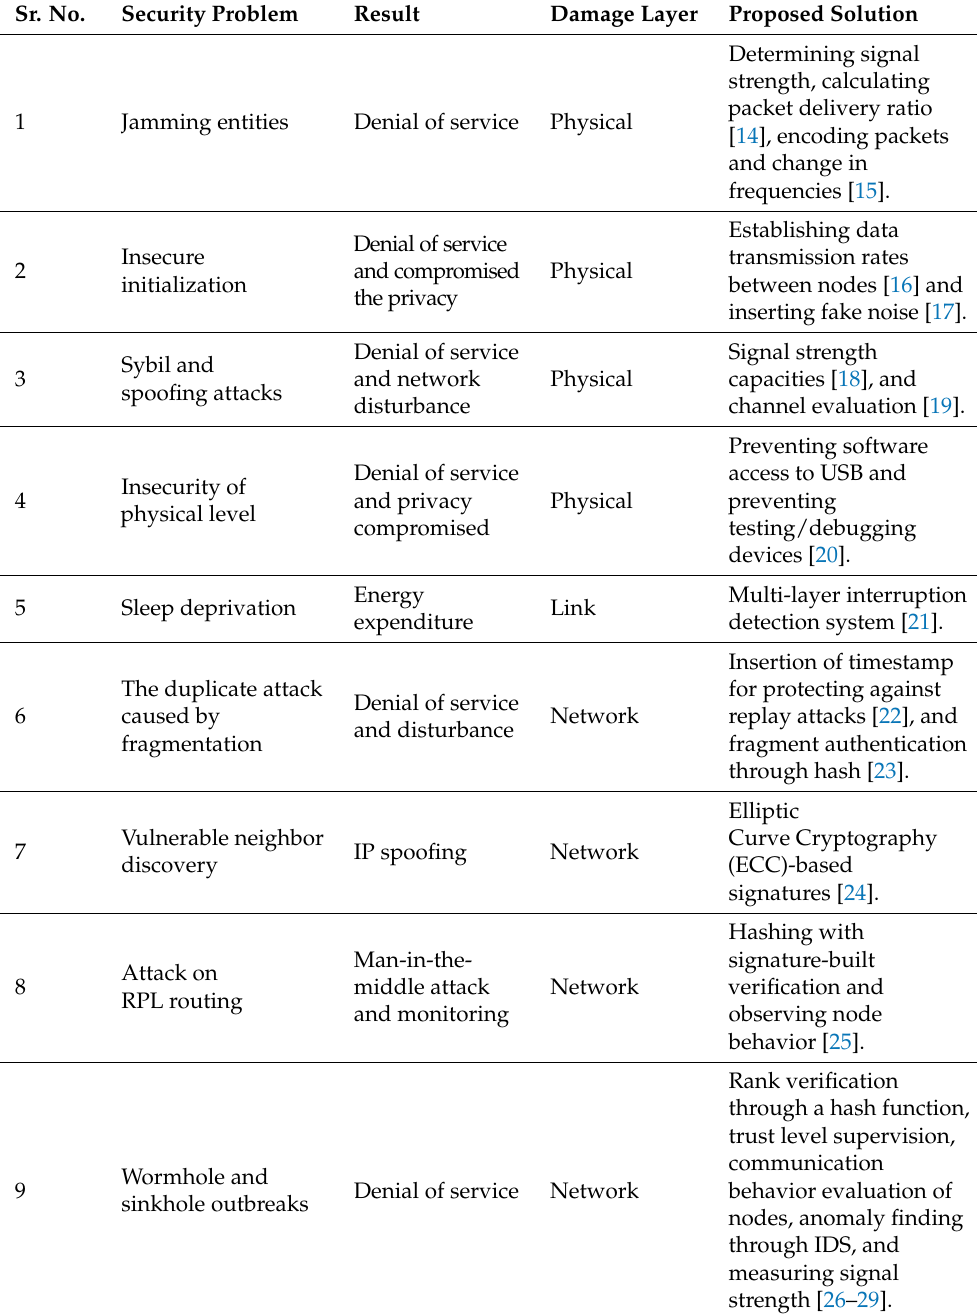
Table 2. Security issues of IoT at different layers and their proposed solutions. Sr.